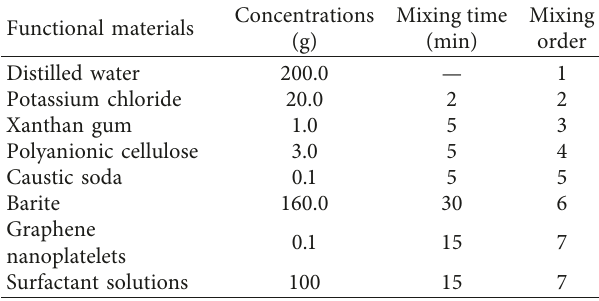
Figure 1: Chemical structure of (a) DTAB, (b), SDS, and (c) Triton Table 1: Drilling fluid formulations and mixing procedure.